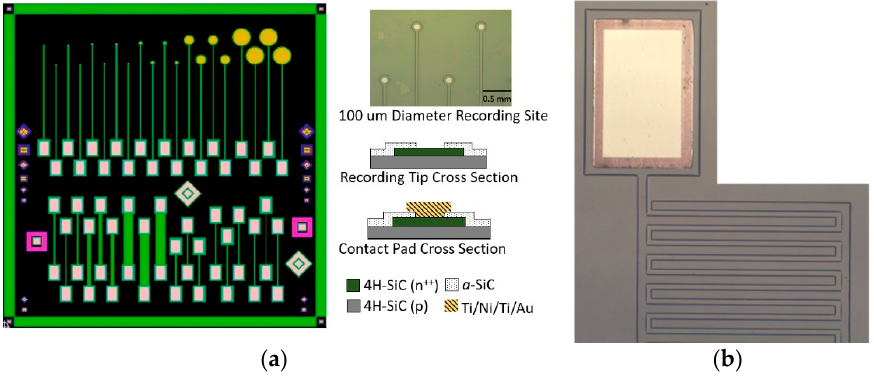
Figure 1. All ‐ SiC planar device used for electrical and electrochemical testing. ( a ) Single ‐ ended electrodes (top) with various recording areas (diameters of 25, 50, 100, 400, and 800 μ m) and test structures (bottom) consisting of p ‐ n diodes and resistor mesas of various length and width. An optical micrograph of fabricated all ‐ SiC single ‐ ended electrodes, with 100 μ m diameter active recording sites, is provided (top right). Bright areas are windows in the a ‐ SiC insulator. ( b ) One end of the all ‐ SiC interdigitated electrode (IDE) showing a metal contact pad (top) and a portion of the two interdigitated 50 μ m wide mesas of n + on p base layer with a pitch of 25 μ m.